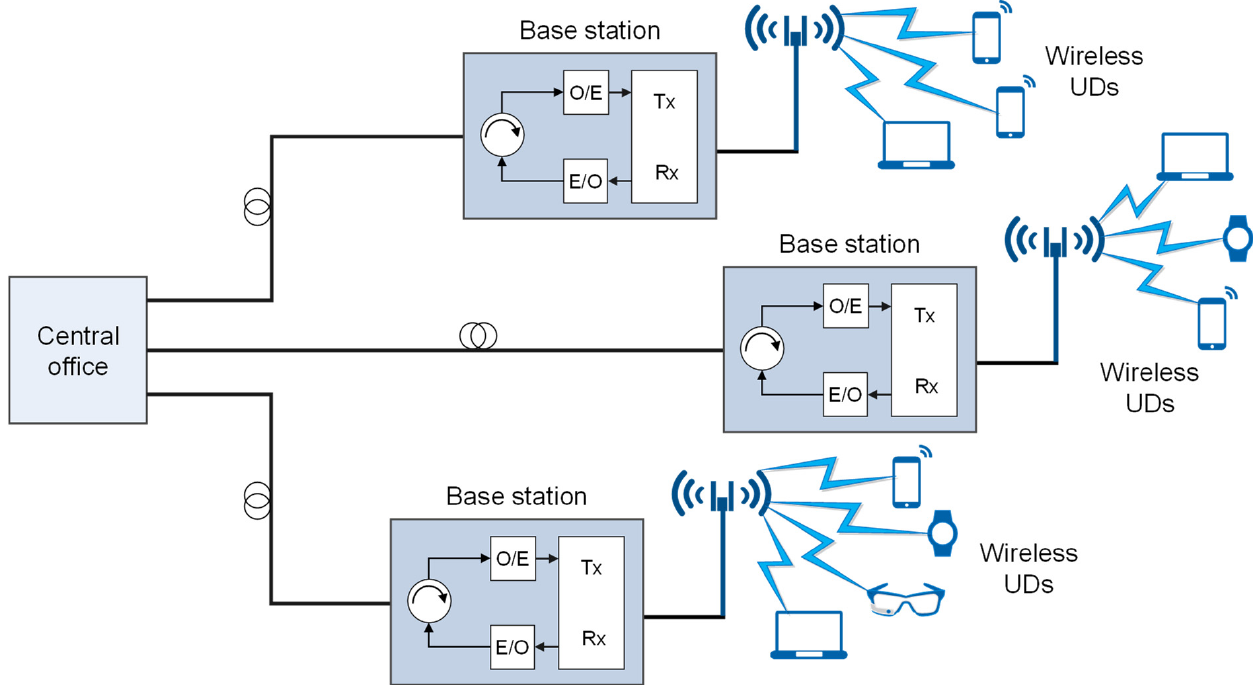
Figure 4. Generic RoF architecture.